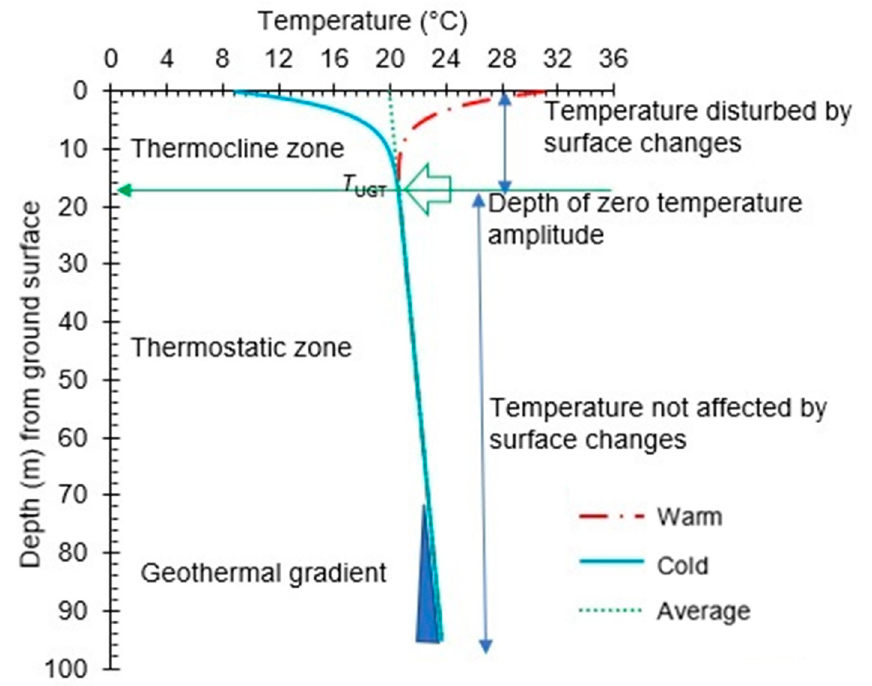
Figure 1. Theoretical ground temperature distribution showing the depth of zero temperature amplitude. The blue triangle indicates the geothermal